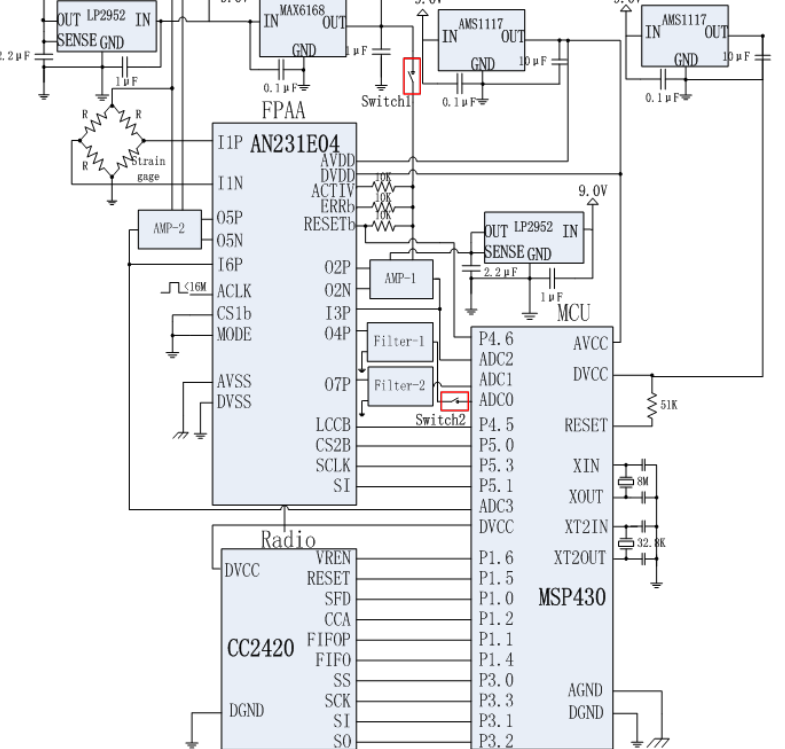
Figure 5. Circuit design of the redundancy-based self-healing node.